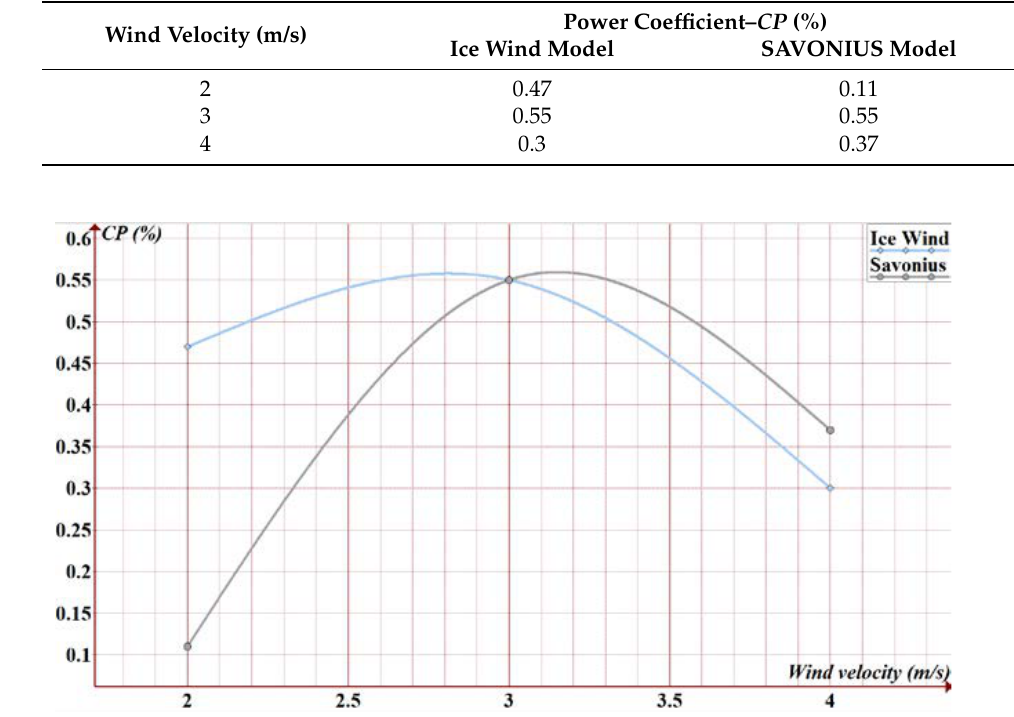
Figure 20. CP values for the aluminium ice wind rotor versus the SAVONIUS rotor [87].